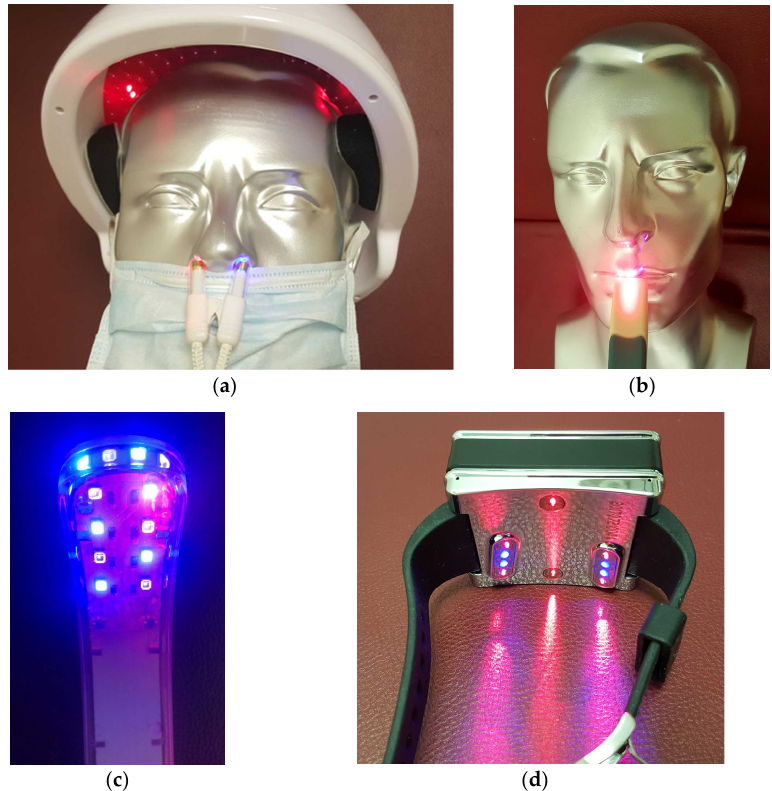
Figure 2. Examples of stimulation equipment for photobiomodulation and photodynamic therapy from the own research area of the TCM Research Center of the Medical University of Graz. In addi- tion to the transcranial LED (light emitting diode) stimulation ( a ), a light stimulus application is possible via a nose adapter ( a ) (red, infrared, blue, or ultraviolet light irradiation) and a sublingual adapter ( b ). Local application using a so-called throat adapter ( c ) or systemic treatment using blood irradiation in the area of the radial and ulnar arteries using a so-called “laser watch” ( d ) [31] is also entirely conceivable. In addition to the blood irradiation, important acupuncture points in the area of the wrist groove can also be stimulated.